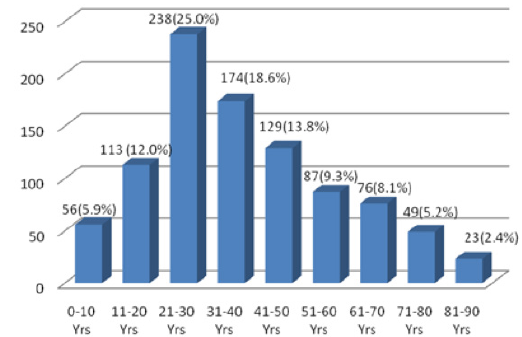
Figure1: Distribution of clinical isolates of Enterobacteriaceae ac- cording to the age of the patients, (n=936)